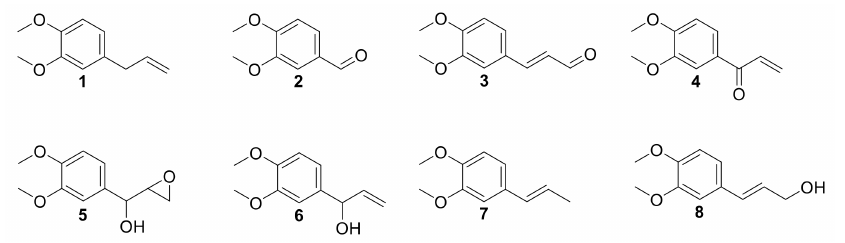
Figure 1. Methyl eugenol 1 and